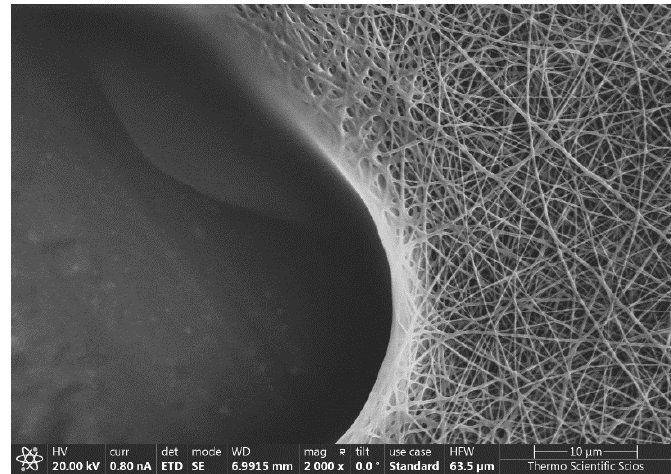
Figure 6. An example of an SEM image of a native sample (G 1 ) after placing one drop water on the surface and allowing it to dry in air, at room temperature.